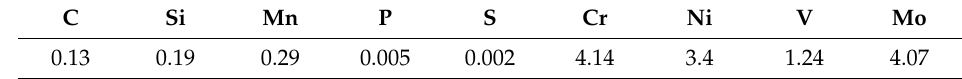
Table 1. Composition (wt.%) of M50NiL steel.